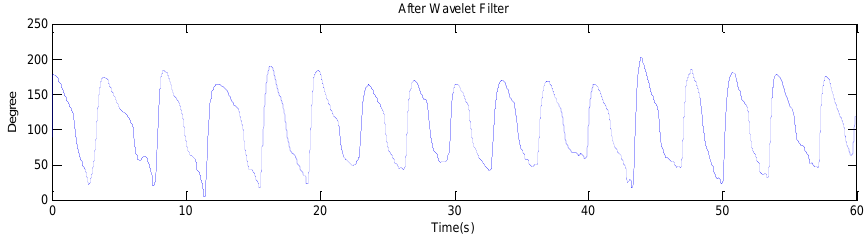
Figure 11. Normal breathing pattern after filtration.